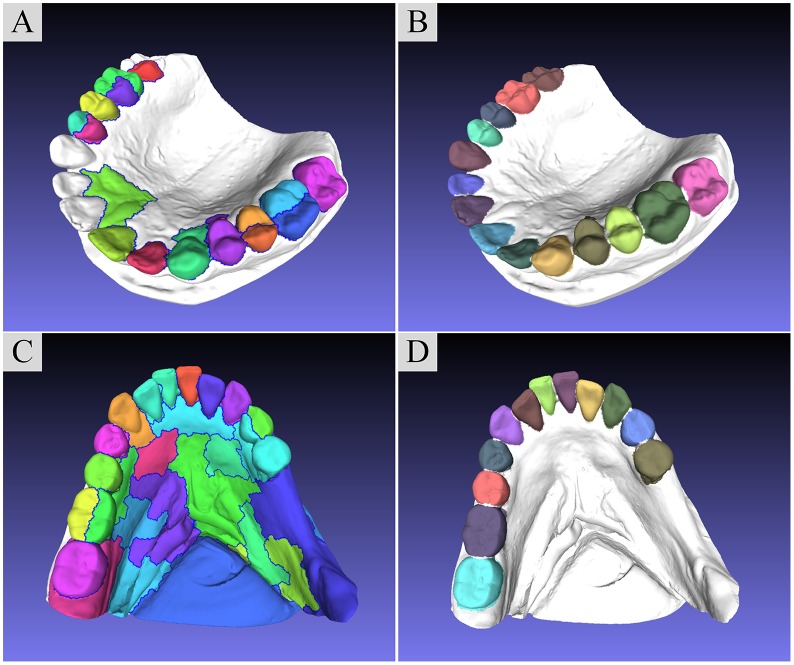
The comparison between our method and the segmentation algorithm presented by [28].(A) and (C) are the segmentation result of [28] with model case B and case D in Fig 6, and (B) and (D) are the correspond segmentation results of our method. The average time consumption of single tooth separation in A and C were 42629ms and 159208ms, and the correspond time consumption in B and D were 1319ms and 3279ms, respectively.